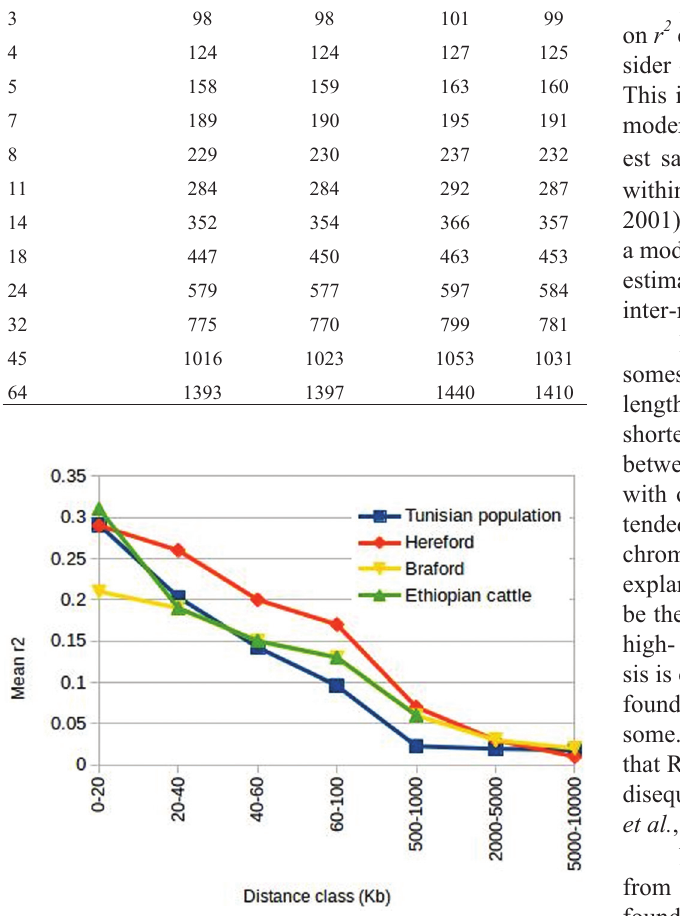
Figure 4 - Decay in linkage disequilibrium ( r 2 ) over increasing inter-